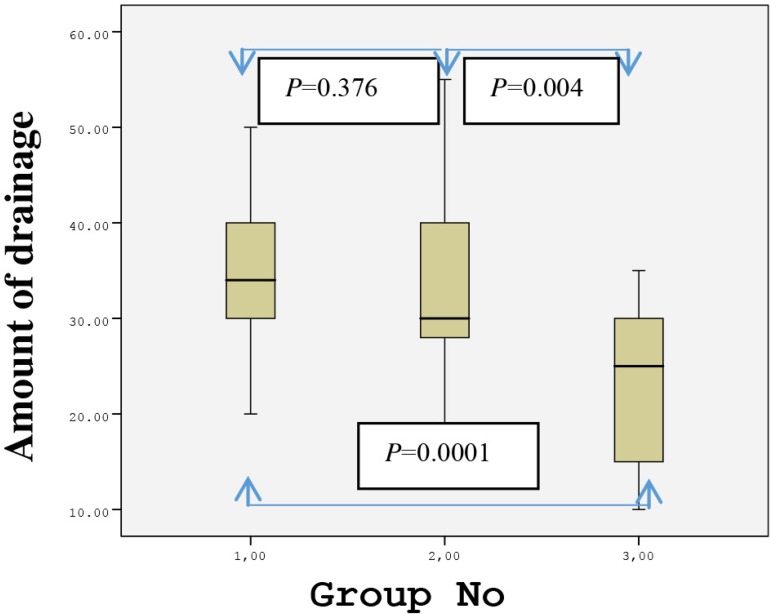
Distribution of 48-hour drainage amount between the groups.Group 1=classical method (using sharp dissection); Group 2=electrocautery; Group 3=ultrasonic cautery